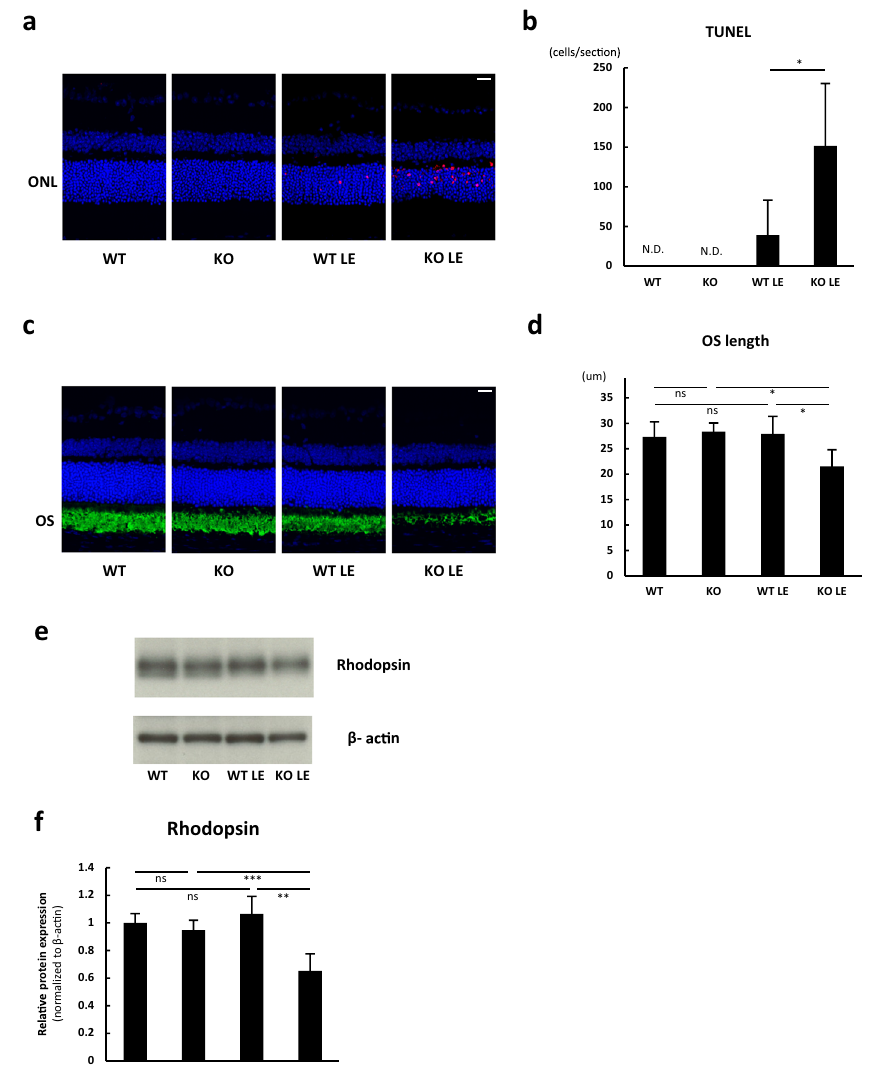
Fig. 3 SIRT3 KO retinas showed increased cell death after the light exposure (LE). a Representative images of terminal deoxynucleotidyl transferase dUTP nick end labeling (TUNEL) stain for WT and SIRT3 KO retinas without and with LE (36 h after LE). Blue: DAPI, Red: TUNEL. Scale bars: 20 μ m. ONL outer nuclear layer. b Comparison of TUNEL-positive cell counts per section ( n = 4 per group). * p < 0.05 by two-tailed unpaired t -test. c Representative images of Immunostaining of Rhodopsin for WT and SIRT3 KO retinas without and with LE (36 h after LE). Blue: DAPI, Green Rhodopsin. Scale bars: 20 μ m. OS outer segment. d Comparison of outer segment (OS) length (36hr after LE, WT: n = 4, KO: n = 4, WT LE: n = 5, KO LE: n = 6). * p < 0.05 by one-way ANOVA with post hoc Tukey ’ s HSD test. e, f Immunoblot of Rhodopsin for WT and SIRT3 KO retinas without and with LE (36 h after LE, WT: n = 4, KO: n = 4, WT LE: n = 5, KO LE: n = 6). ** p < 0.01 and *** p < 0.001 by one-way ANOVA with post hoc Tukey ’ s HSD test. Values are mean ±